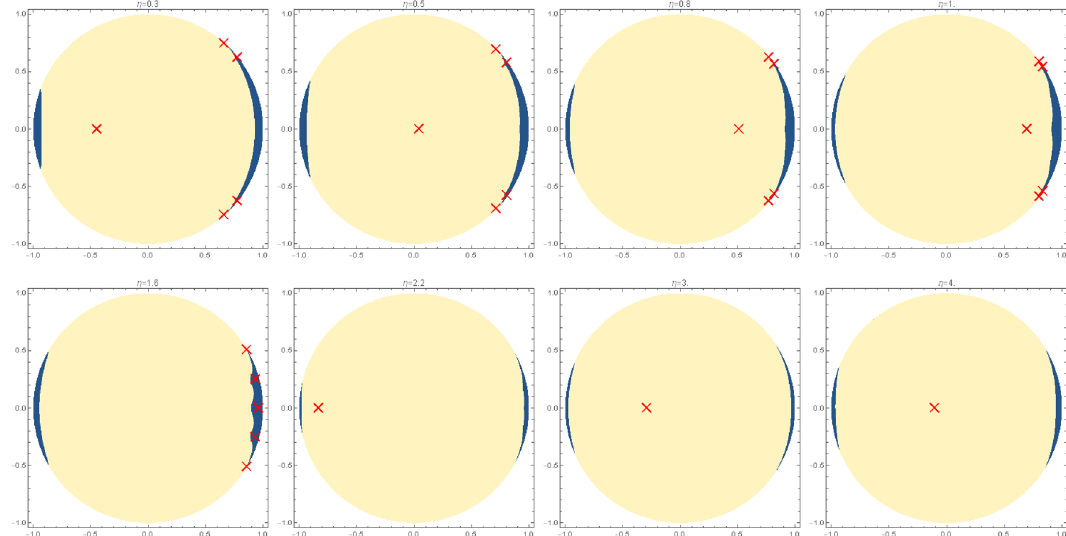
Figure 10. The exclusion plots of unknown resonances on the z -disc, for a set of η values ranging from 0 . 2 to 4. The possibility of zeros of S ( z ) is eliminated in the yellow region. The zeros assumed for the fit are marked by red crosses.